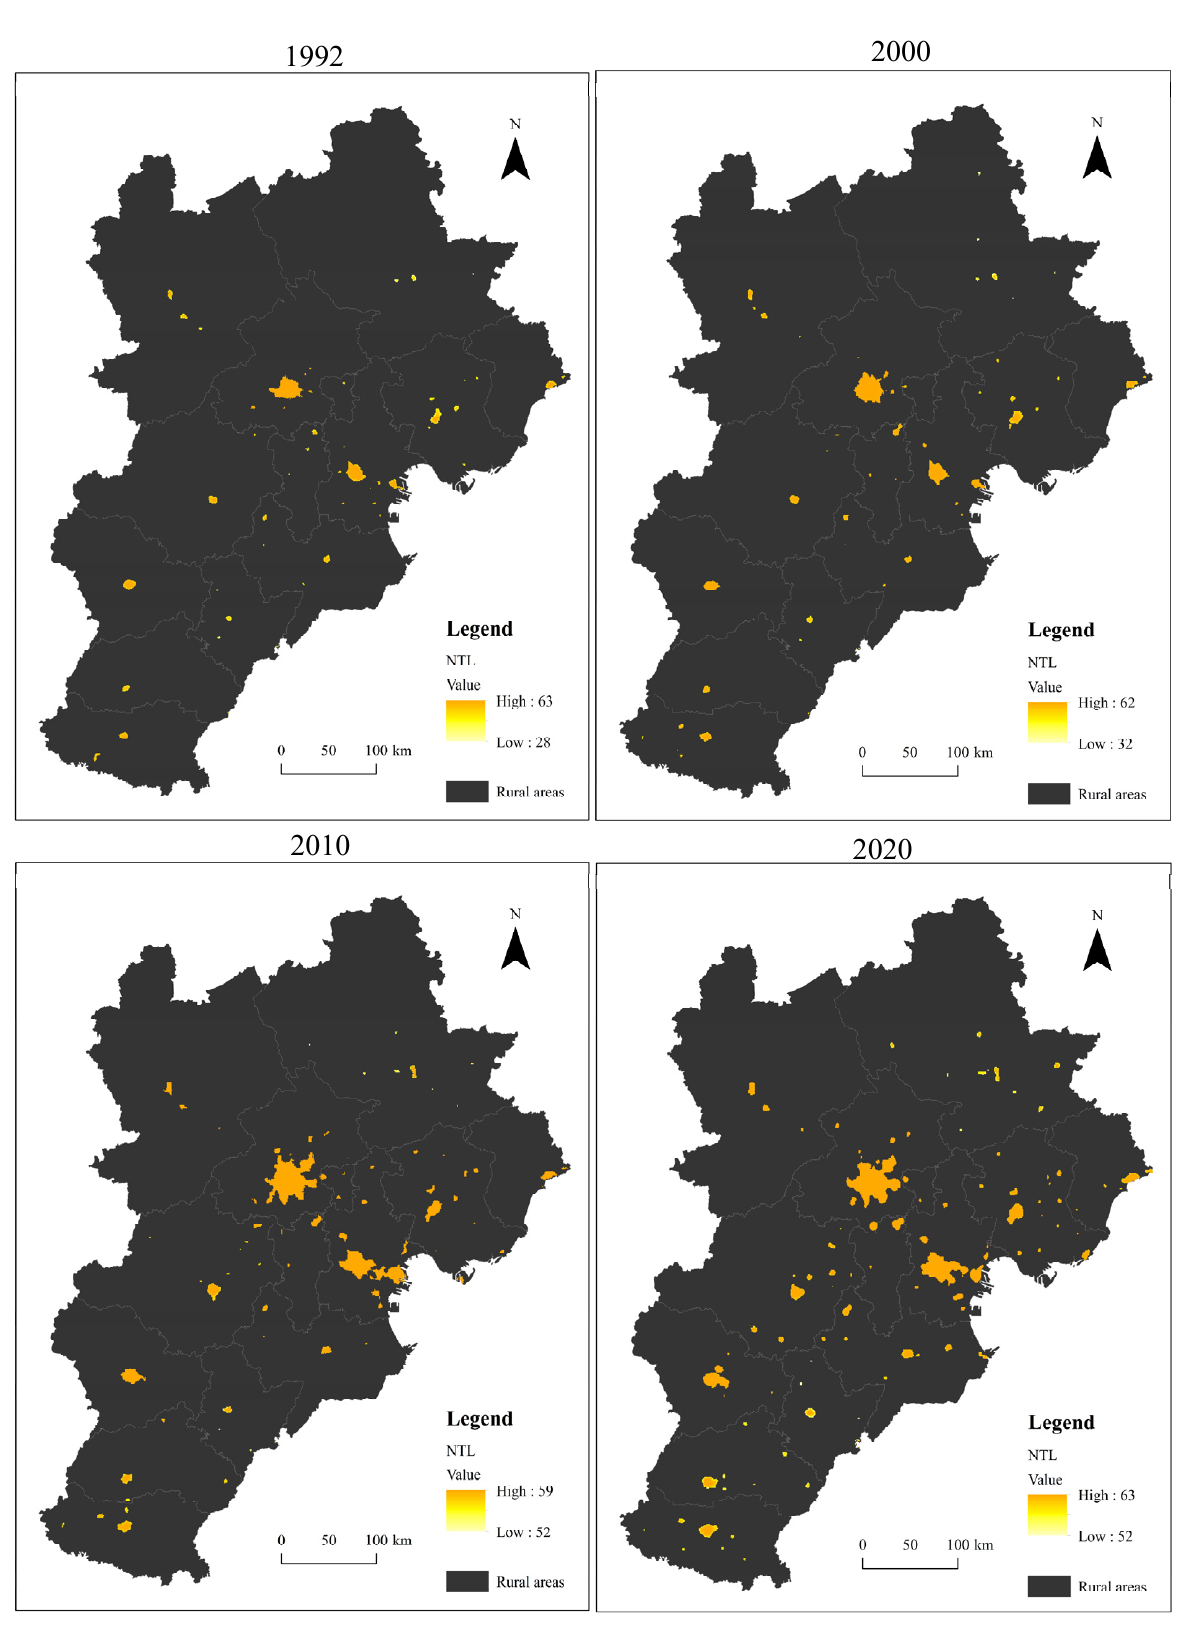
Figure 2. Urban Built-up Areas Extraction Results in the Beijing–Tianjin–Hebei Urban Agglomeration in 1992, 2000, 2010 and 2020.